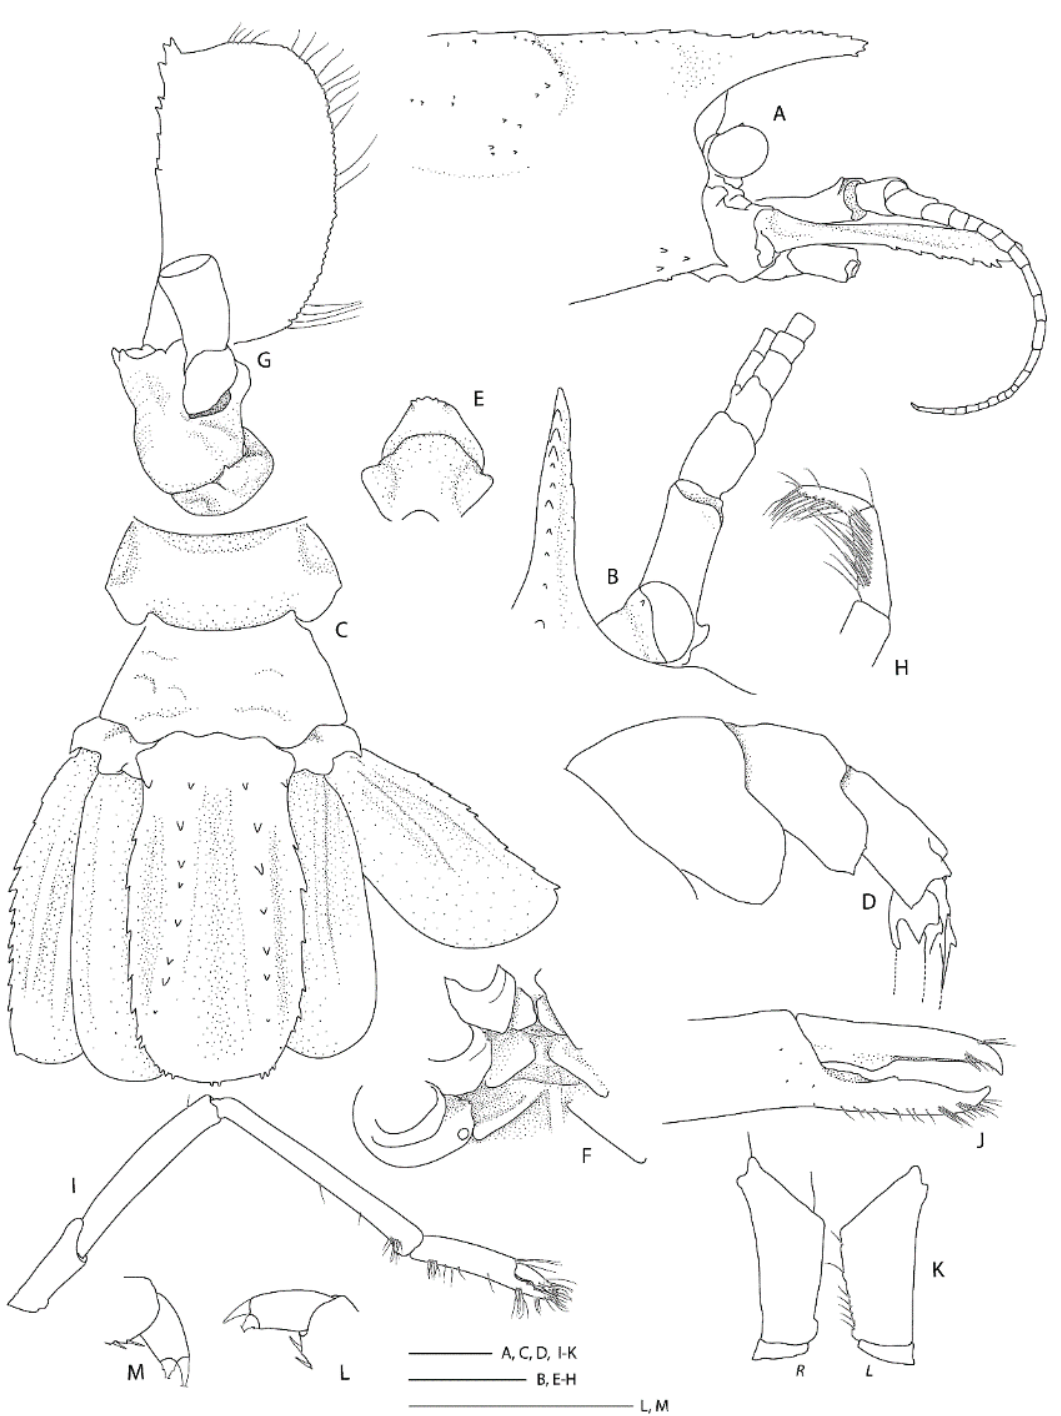
Figure 8. Spongicoloides novaezelandiae Baba, 1979 [20], holotype M (NMNZ CR.001889). ( A ) Anterior carapace and cephalic appendages, lateral. ( B ) Rostrum, right ocular peduncle and antennule, dorsal. ( C ) Pleonites 5 and 6, urosome and telson, dorsal. ( D ) Pleonites 4–6 and proximal urosome and telson, lateral. ( E ) Epistome and labrum, ventral. ( F ) Thoracic sternites 6–8 with coxae of pereiopods, ventral. ( G ) Right antenna, ventral. ( H ) Distal portion of Mxp3 showing the setiferous organ on propodus. ( I ) Right P1, lateral. ( J ) P3 fingers and distal palm, mesial. ( K ) Right ( R ) and left ( L ) ischia of P3, lateral. ( L ) Left P4 or P5 dactylus and distal propodus. ( M ) Right P5 dactylus and distal propodus. Scale bars = 2 mm.